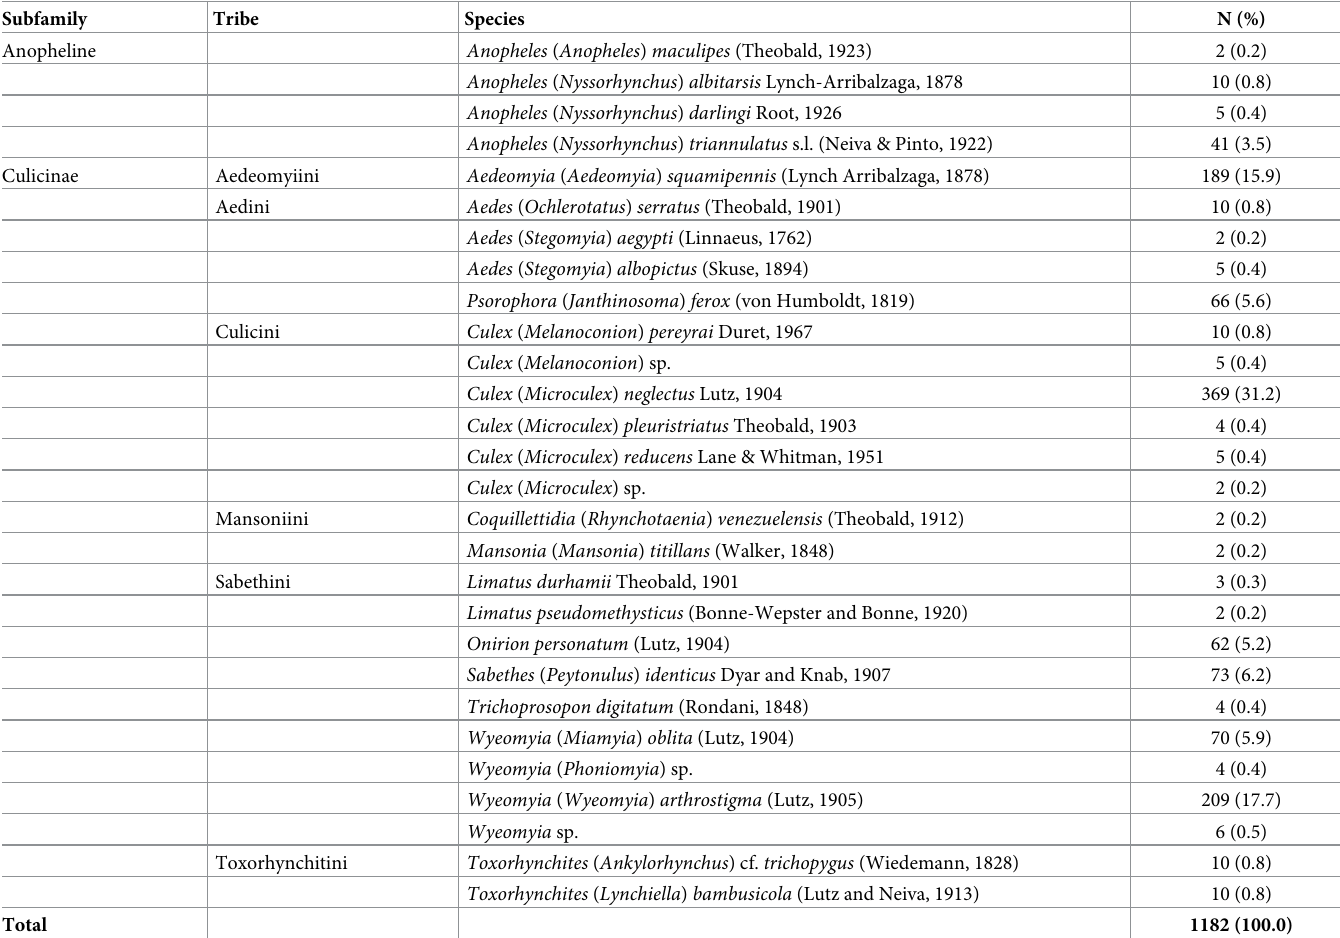
Table 1. Mosquito taxa collected from June 2014 to June 2015 in breeding sites located at the Poc¸o das Antas Biological Reserve in southeastern Brazil. Subfamily